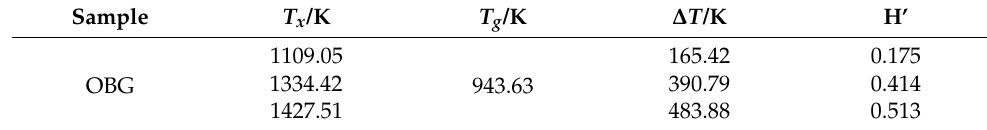
Table 3. Characteristic temperature and stability parameters of the OBG at 10 °C/min.